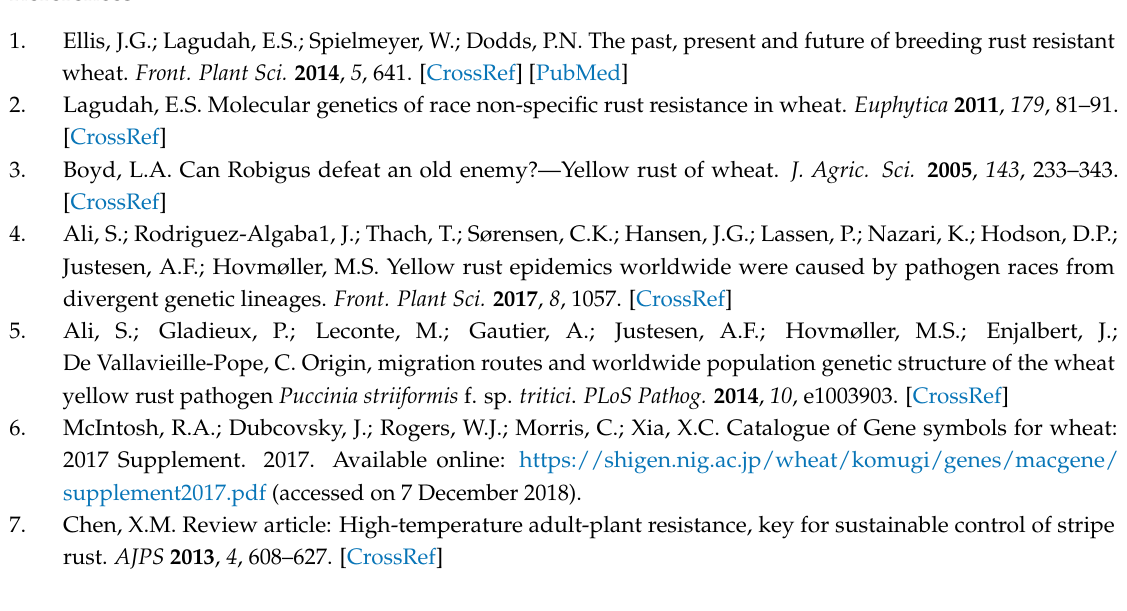
Table S1: Predicted Puccinia striiformis f. sp. tritici race 6E22A+ adult plant resistance quantitative trait loci (QTL) retained by selected Palmiet × Yr16DH70 F 8 recombinant inbred lines (RILs), scanned for all DNA markers across each QTL interval, Table S2: Nucleotide sequence, annealing temperature and amplification efficiency for primer pairs used during quantitative reverse transcription polymerase chain reaction